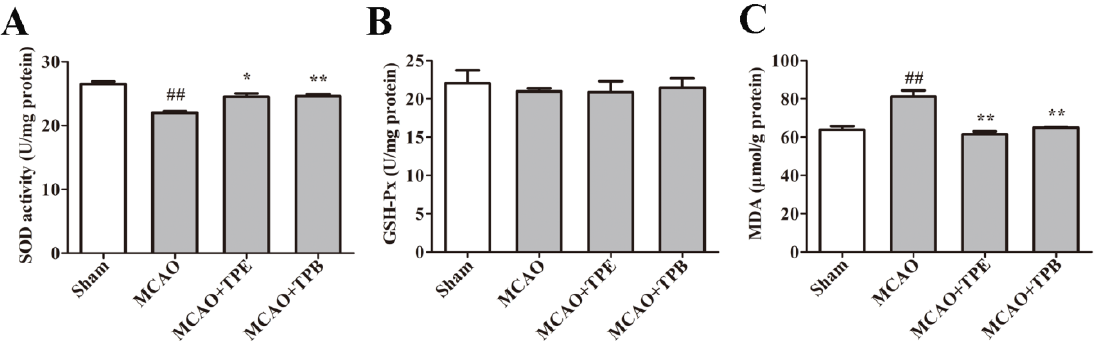
Figure 7. TPE and TPB protection of the brain from cerebral ischemia/reperfusion injury was measured by quantifying SOD activity ( A ), GSH-P x levels ( B ) and MDA levels ( C ). ## p < 0.01 vs. sham group, * p < 0.05, ** p < 0.01 vs. MCAO group.